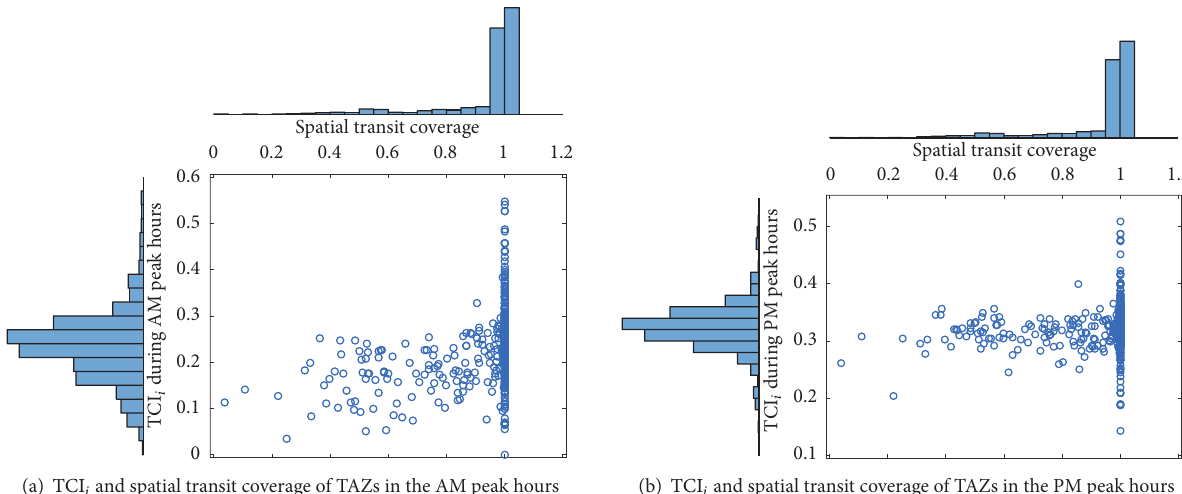
Figure 8: Comparison of TCI 𝑖 with the spatial transit coverage during AM and PM peak hours ( 𝑑 = 1000m, 𝛼 =